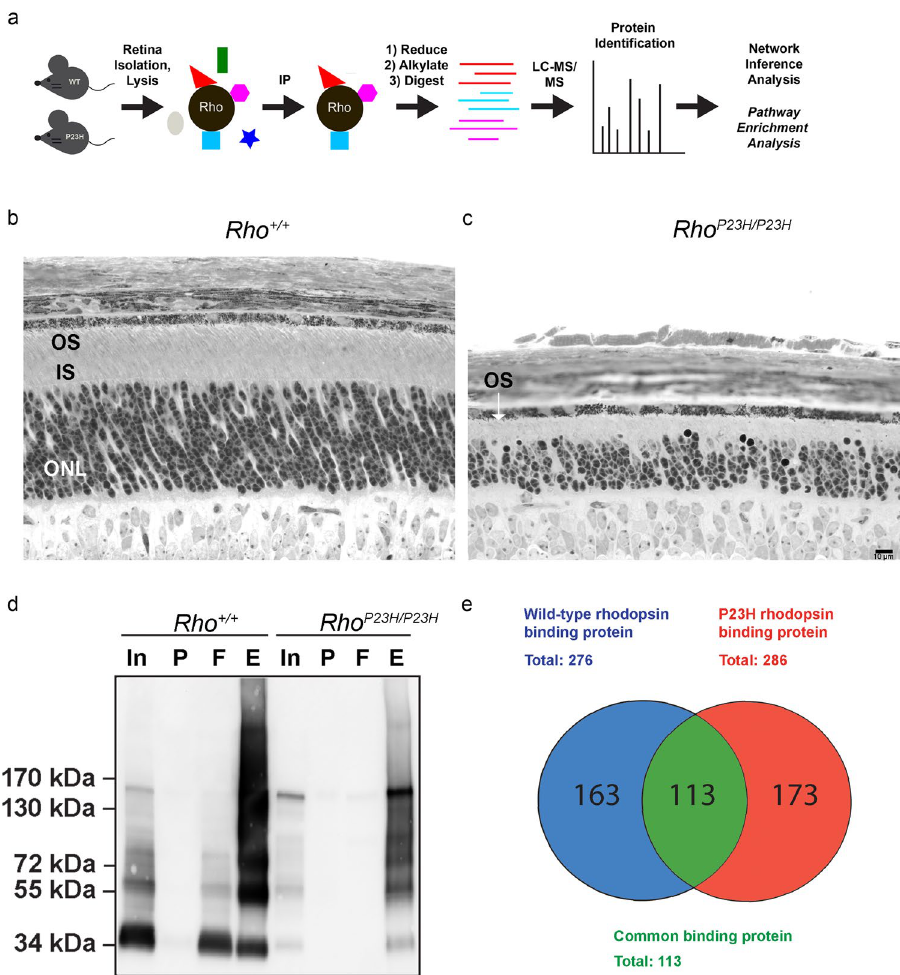
Figure 1. Identification of wild-type and P23H rhodopsin-interacting proteins from Rho + / + and Rho P23H/P23H mouse retina. ( a ) Graphical summary of the experimental design. Liquid chromatography-mass spectrometry (LC–MS/MS) was performed on wild-type or P23H rhodopsin immunopurified from Rho + / + or Rho P23H/P23H mouse retinas. ( b, c ) Light micrographs of Rho + / + ( b ) and Rho P23H/P23H ( c ) mouse retinas at postnatal day 15 (scale represents 10 µm). The white arrow refers to the location of the degenerating outer segment (OS) in Rho P23H/P23H mice. IS, inner segment. ONL, outer nuclear layer. ( d ) Western blots of Rho + / + and Rho P23H/P23H P15 mouse retina protein lysate fractions probed for rhodopsin (anti-rhodopsin, 1D4). In, input. P, pellet. F, flow-through. E, eluate. Uncropped blots are shown in Supplementary Information 1. ( e ) Venn diagram of